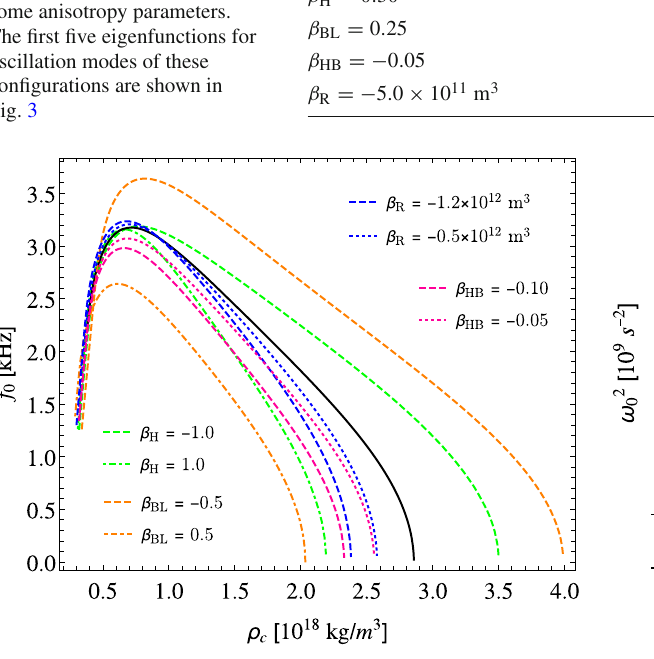
Fig. 4 On the left panel is shown the frequency of the fundamental mode f 0 = ω 0 / 2 π as a function of the central mass density ρ c , and on the right panel is displayed the squared frequency of the fundamental